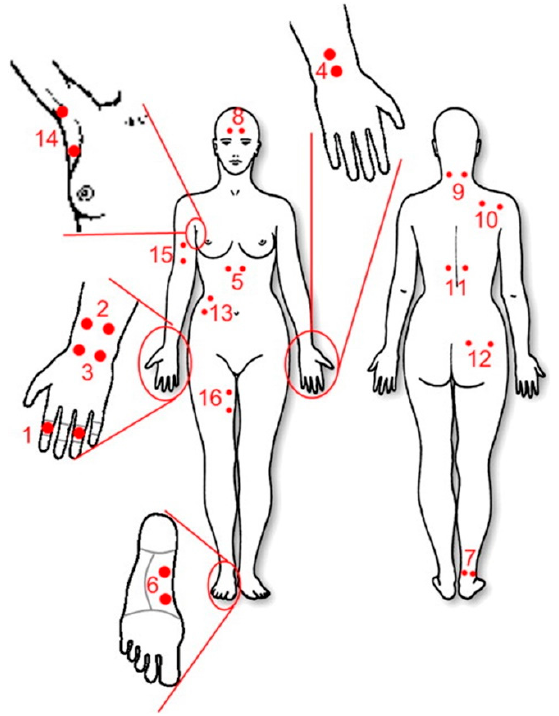
Figure 6. Possible places for attaching GSR electrodes [86].